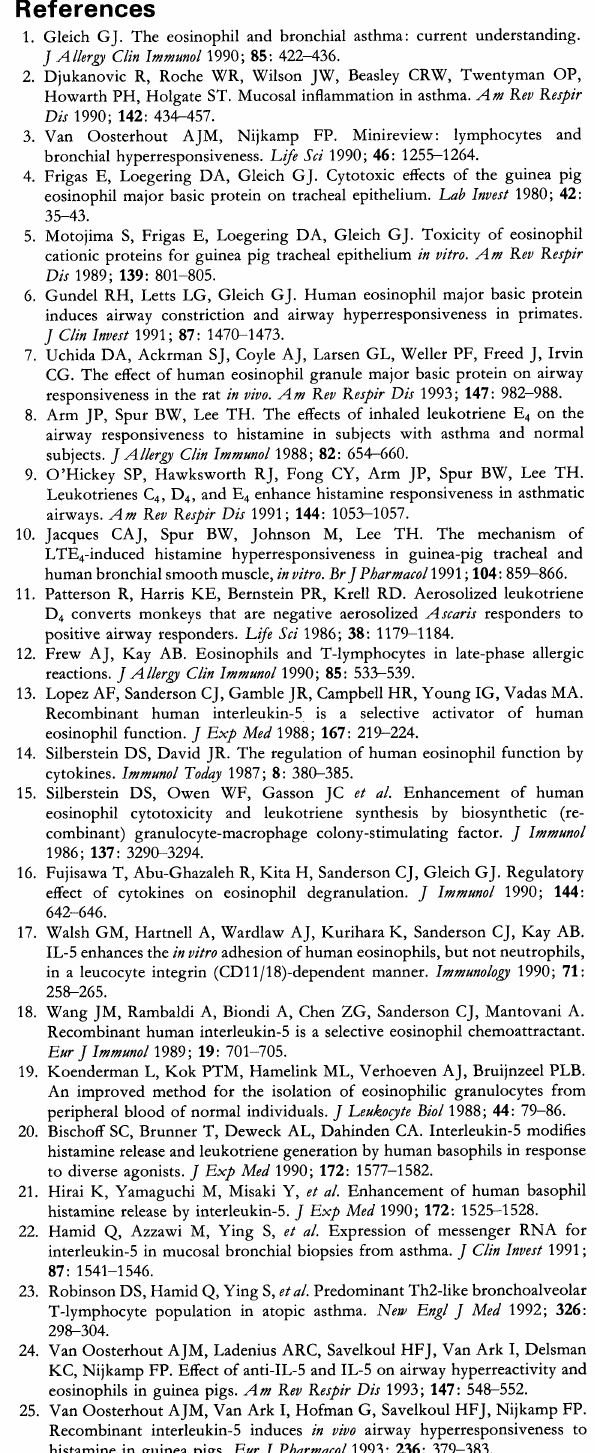
Table 3. Three individual experiments illustrating the donor- to-donor variation in STZ-induced leukotriene C,/D,/E, synthesis (ng/106 cells) and the enhancement by IL-5 in human eosinophils. IL-5 and the stimulating agents were added